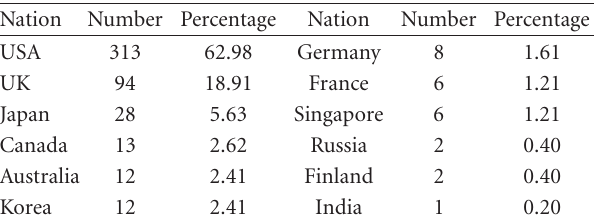
Table 1: Foreign literature numbers in the teacher